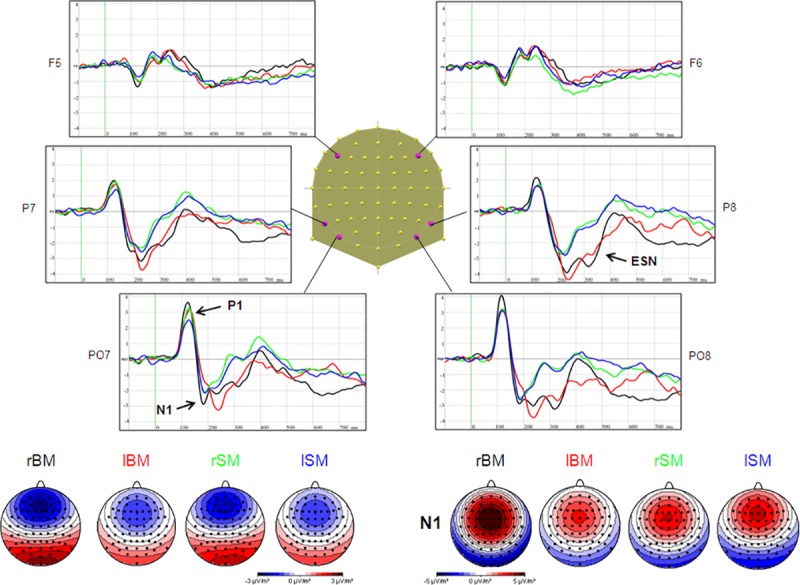
ERPs and scalp current density maps of the four different conditions.Radial (rBM in black) and lateral (lBM in red) biological motion, as well as radial (rSM in green) and lateral (lSM in blue) scrambled motion are represented over 6 electrodes (4 posterior and 2 anterior). Below: scalp current density maps of P1 (right) and N1 (left) components, representing the four conditions, are computed on the mean between 170 ms and 200 ms, and between 80 ms and 150 ms respectively.